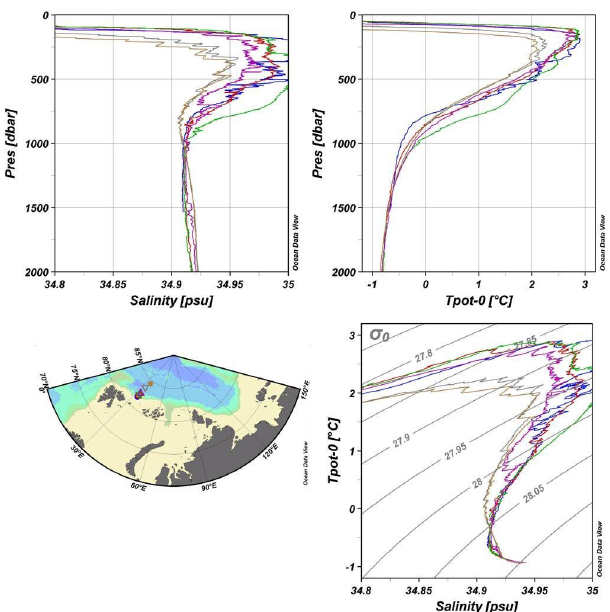
Fig. 7 . Profiles of salinity and potential temperature and θS curves from the second SPACE section north of Franz Josef Land showing the intrusions of colder and less saline water from the Barents Sea in the water column at the